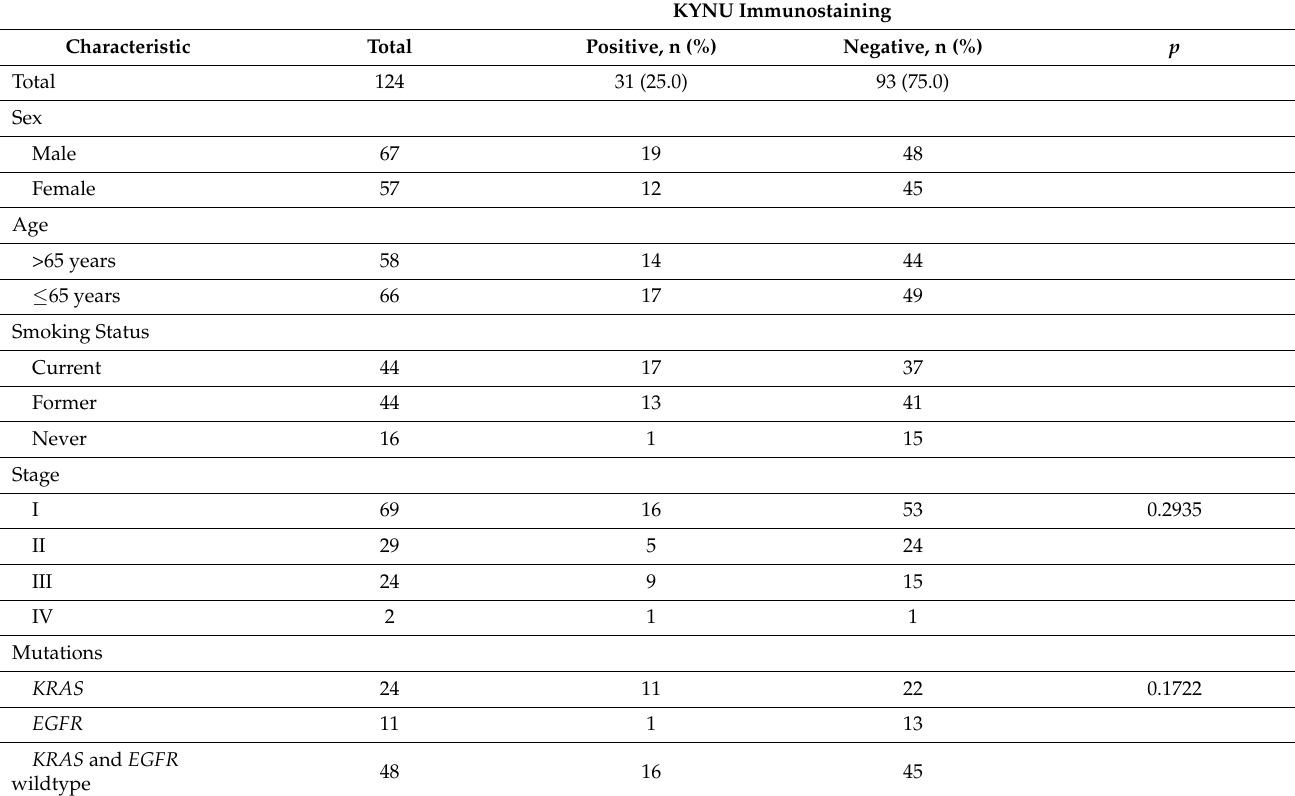
Table A2. Patient characteristics for lung adenocarcinoma TMA.